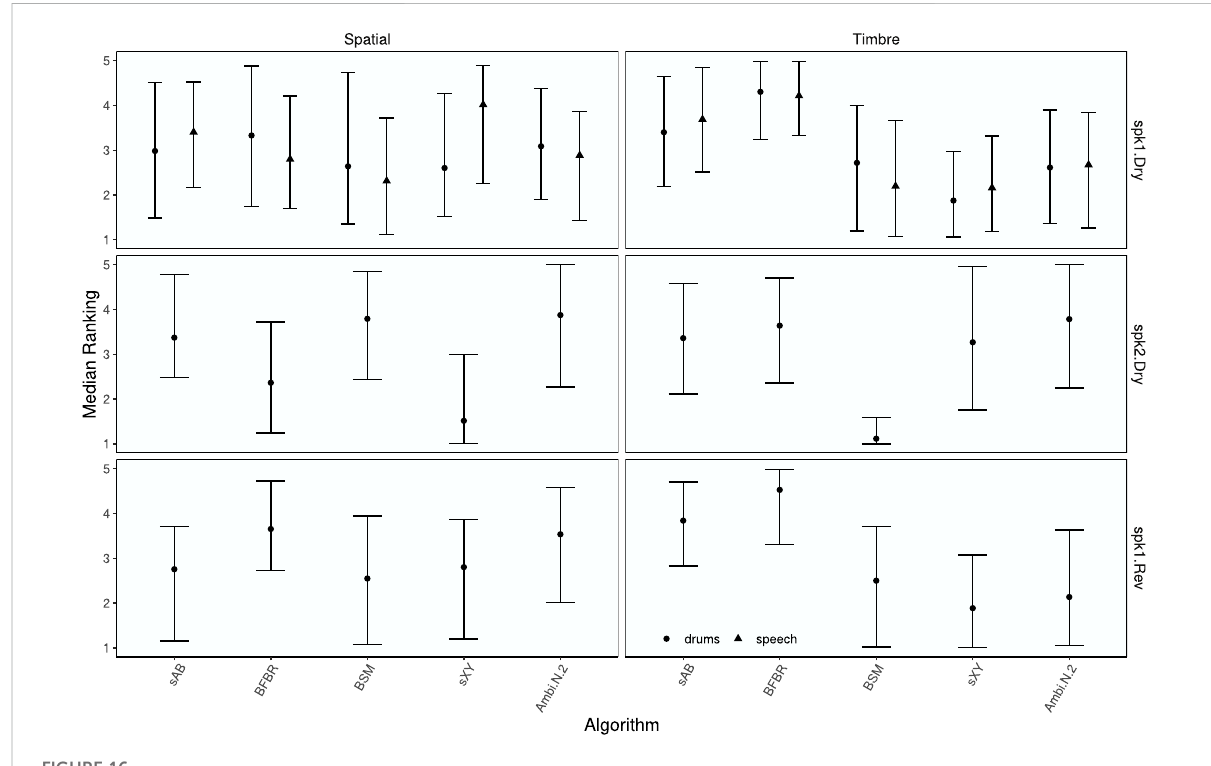
FIGURE 16 EXPERIMENT 2: Median ranks for each rendering by attribute, array con fi guration, room, test signal, and rendering. Points represent median rank and error bars depict the 89% highest density credible